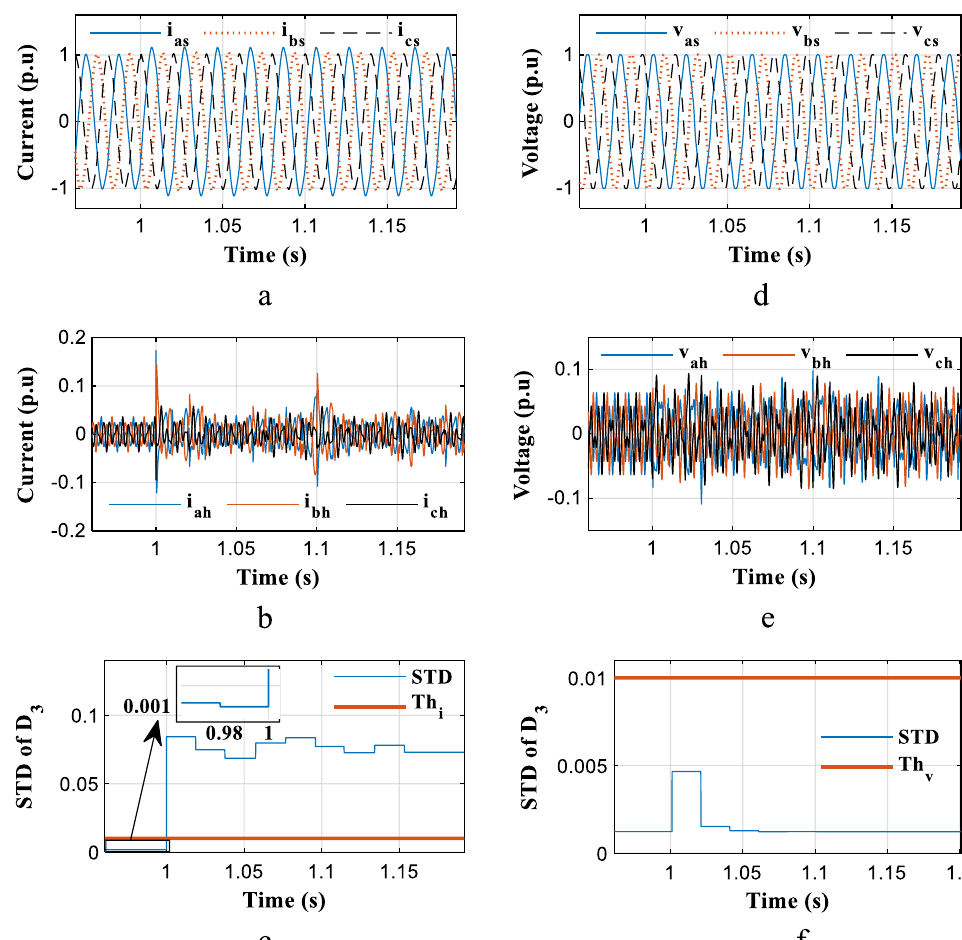
Fig. 9 Performance evaluation of proposed criteria using simulation results for a coil-to-coil fault ( µ = 0.1 ) in a voltage distortion with THD = 5.2% , a Three-phase stator current signals, b High-frequency components of three-phase stator current signals, c The current criterion, d Three-phase stator voltage signals, e High-frequency components of three-phase stator voltage signals, f The voltage